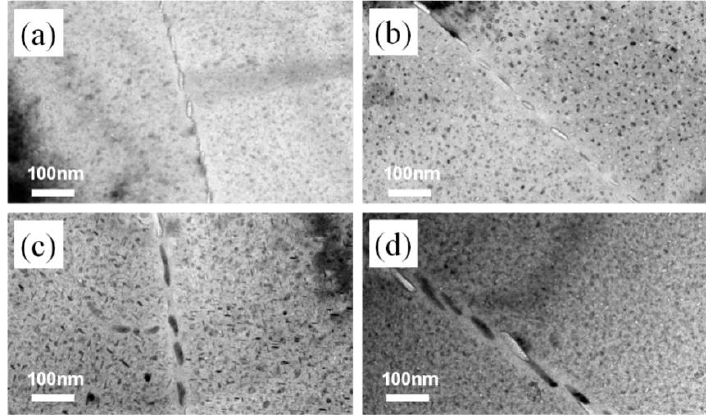
Figure 5. TEM images of the alloys: ( a ) 0.98 wt.%Cu (L-T); ( b ) 0.98 wt.%Cu (S-T); ( c ) 2.02 wt.%Cu (L-T); ( d ) 2.02 wt.%Cu